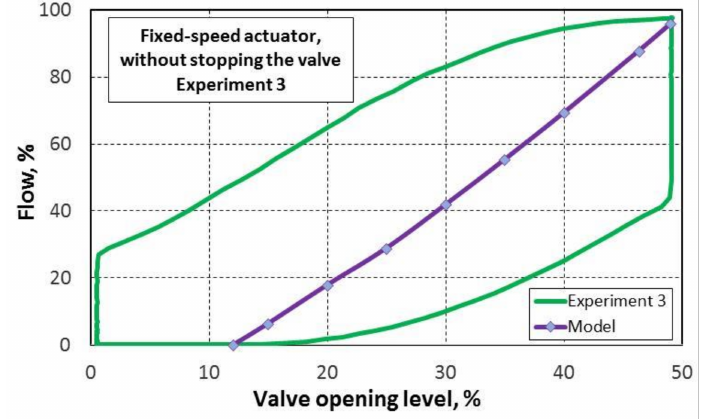
Figure 3. Flow characteristics of the valve with a fixed-speed actuator according to the procedure (O/Z) along with the model characteristics.